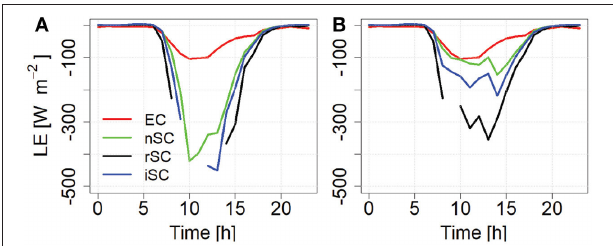
FIGURE 13 | Diurnal cycles for the latent heat flux on clear days assuming full saturation (A) and relative humidity as a function of surface temperature (B) . EC denotes the eddy correlation measurements, nSC the model with no stability correction, rSC based on the Richardson number and iSC iterating over the Monin-Obukhov